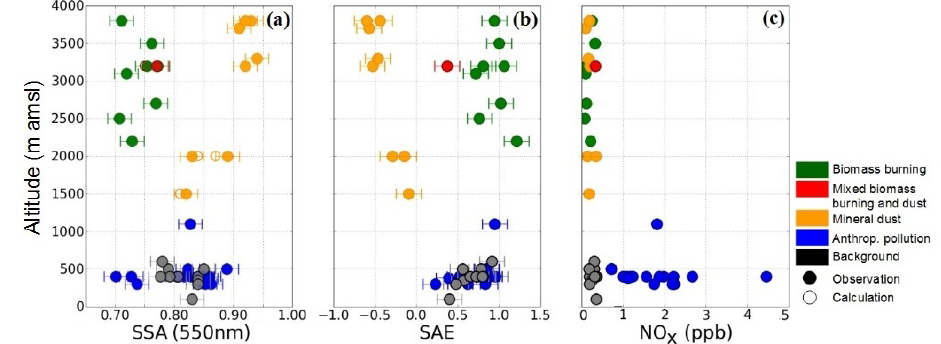
Figure 7. Vertical distribution of (a) the single scattering albedo at 550nm, (b) the scattering Ångstrom exponent and (c) the NO x mixing ratio for the dominant aerosol classification. In panel (a) , full circles represent SSA measurements and empty circles represent composite SSA calculated by deconvoluting size-distribution measurements in mixed dust layers and assuming an external mixing